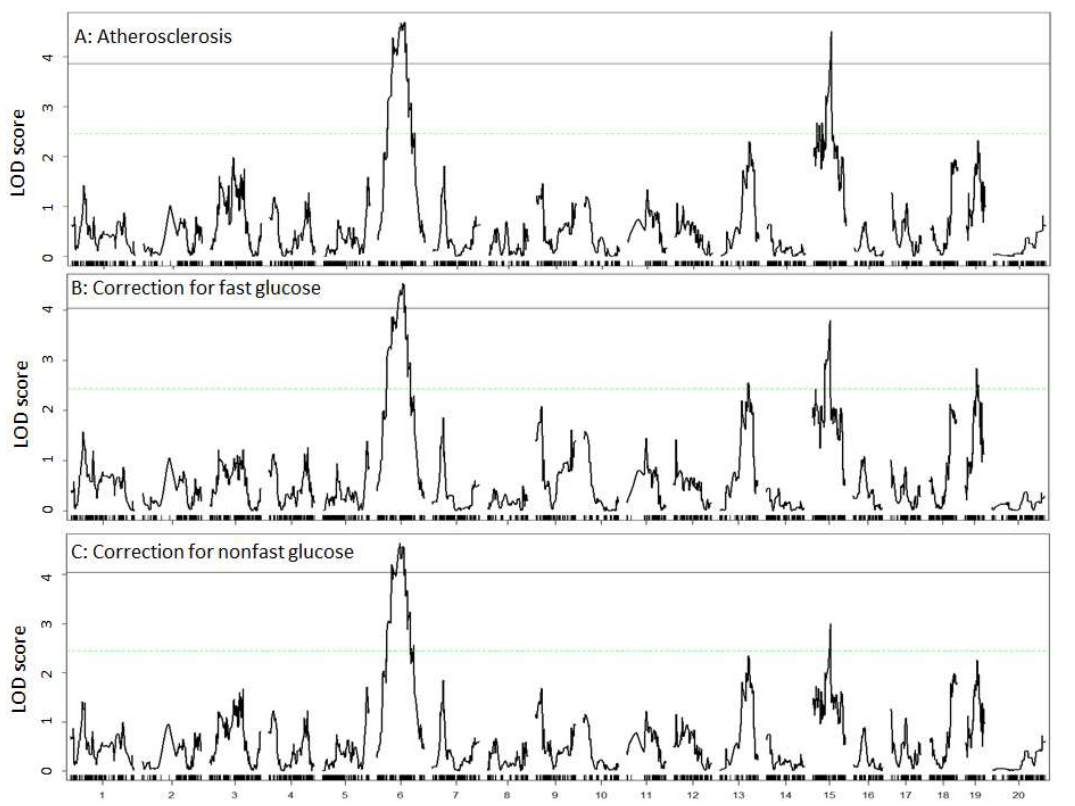
Figure 6. Genome-wide scans to assess the dependence of QTL for carotid atherosclerosis ( A ) on fasting ( B ) and non-fasting plasma glucose levels ( C ) in F2 mice. Residuals from the linear regression analysis of carotid lesion sizes with plasma glucose levels were subject to genome-wide scans. Note the reduced magnitude of the Chr15 QTL for carotid atherosclerosis after correction for fasting and non-fasting glucose. Table 2. Positional candidate genes for Bglu20 on chromosome 15 identified by haplotype